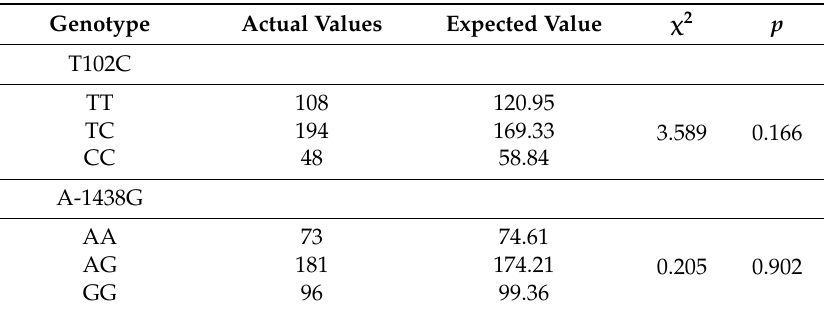
Table 4. Hardy-Weinberg equilibrium